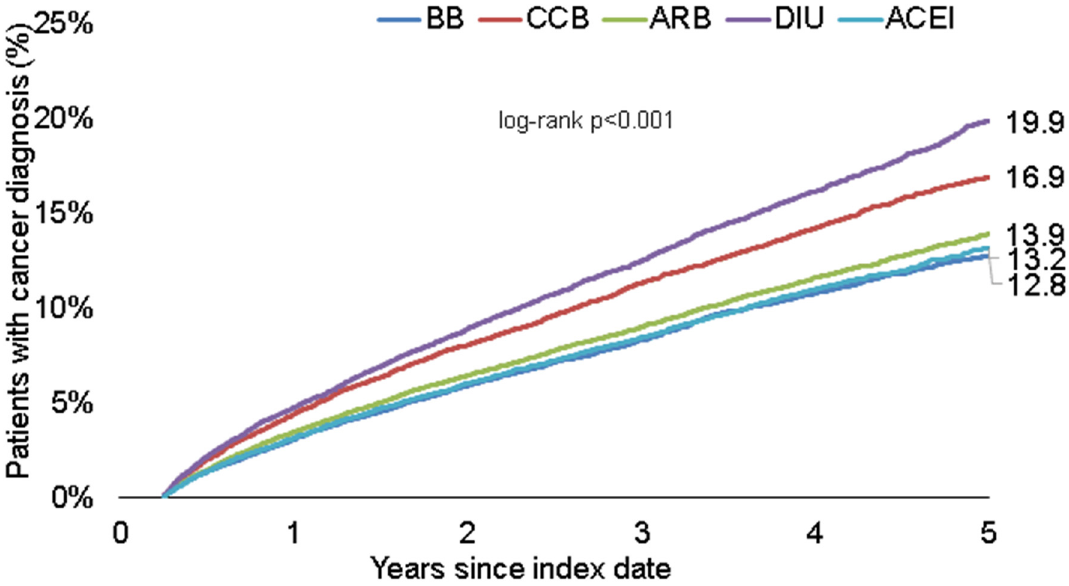
Figure 2. Kaplan–Meier curves showing the time to a cancer diagnosis in patients treated with different antihypertensive drugs. ACEI: ACE inhibitors, BB: beta-blockers, DIU: diuretics, CCB: calcium channel blockers, ARB: angiotensin-II receptor blockers. Table 2. Association between antihypertensive therapy and the incidence of cancer (Cox regression